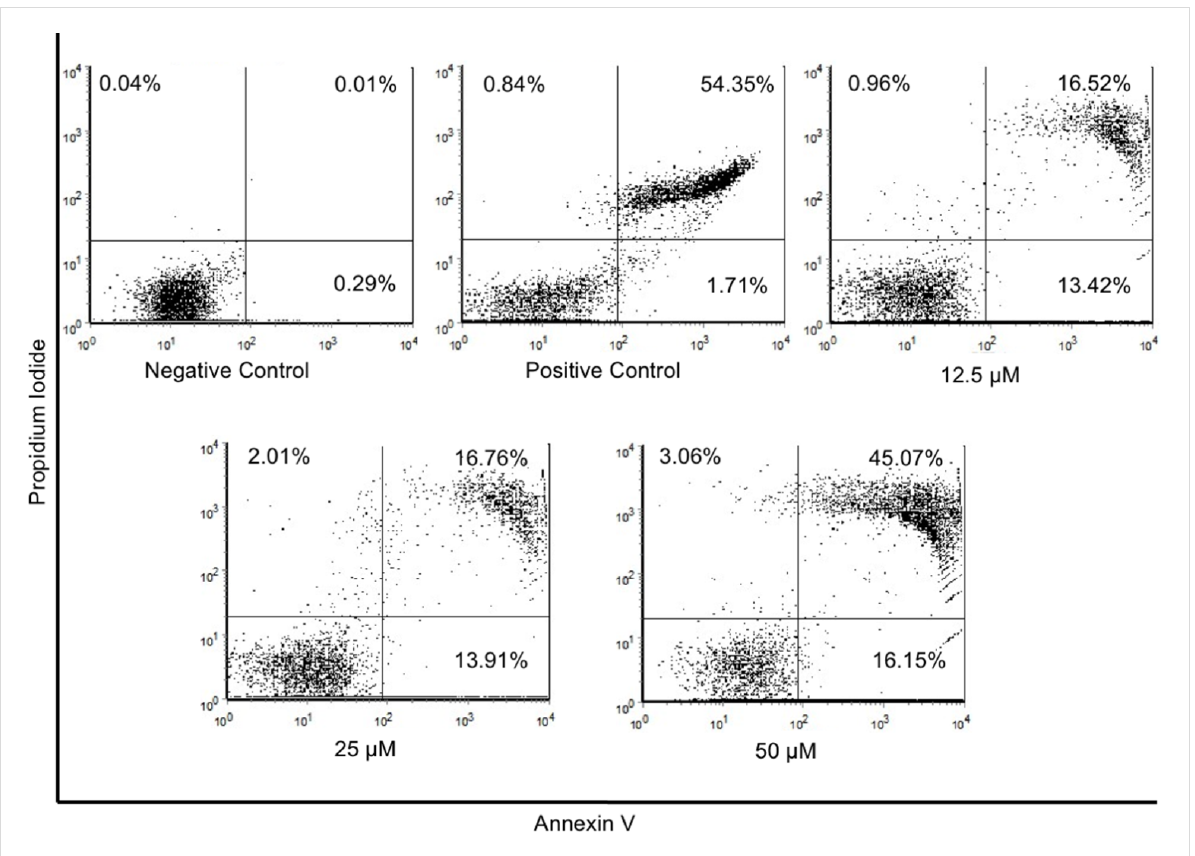
Figure 4: Cell death analysis using flow cytometry. Dot plot graphs from left to right, show cells treated with: (negative control) MCF-7 cells labeled with Annexin/PI, and (positive control) 2.0 μ mol L − 1 staurosporine labeled Annexin V-FITC and PI. Dot plot of MCF-7 cells after exposure to 12.5, 25 or 50 μ mol L − 1 of Dec-NH 2 for 24 h, and flow cytometry analysis with Annexin V-FITC versus PI. The divisions of the plots distinguish necrotic cells (Annexin V+/PI+, right upper quadrant) from apoptotic cells (Annexin V+/PI − , right lower